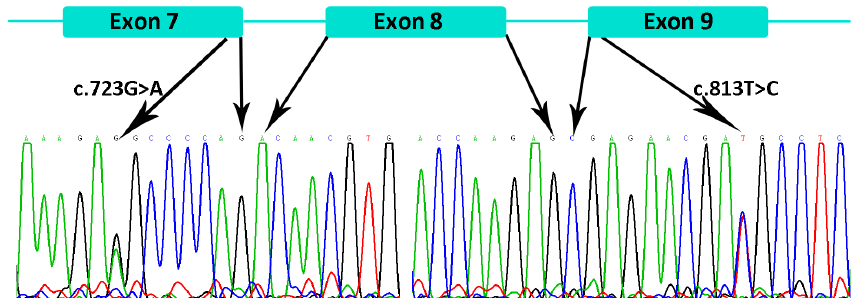
Figure 6. Splicing analysis of EDAR gene with total RNA from the patient in family 7. Exons 7–9 of EDAR gene and sequencing results are showed. The sequencing results indicated normal splicing of EDAR gene with the presence of c.723G>A and c.813T>C variants.